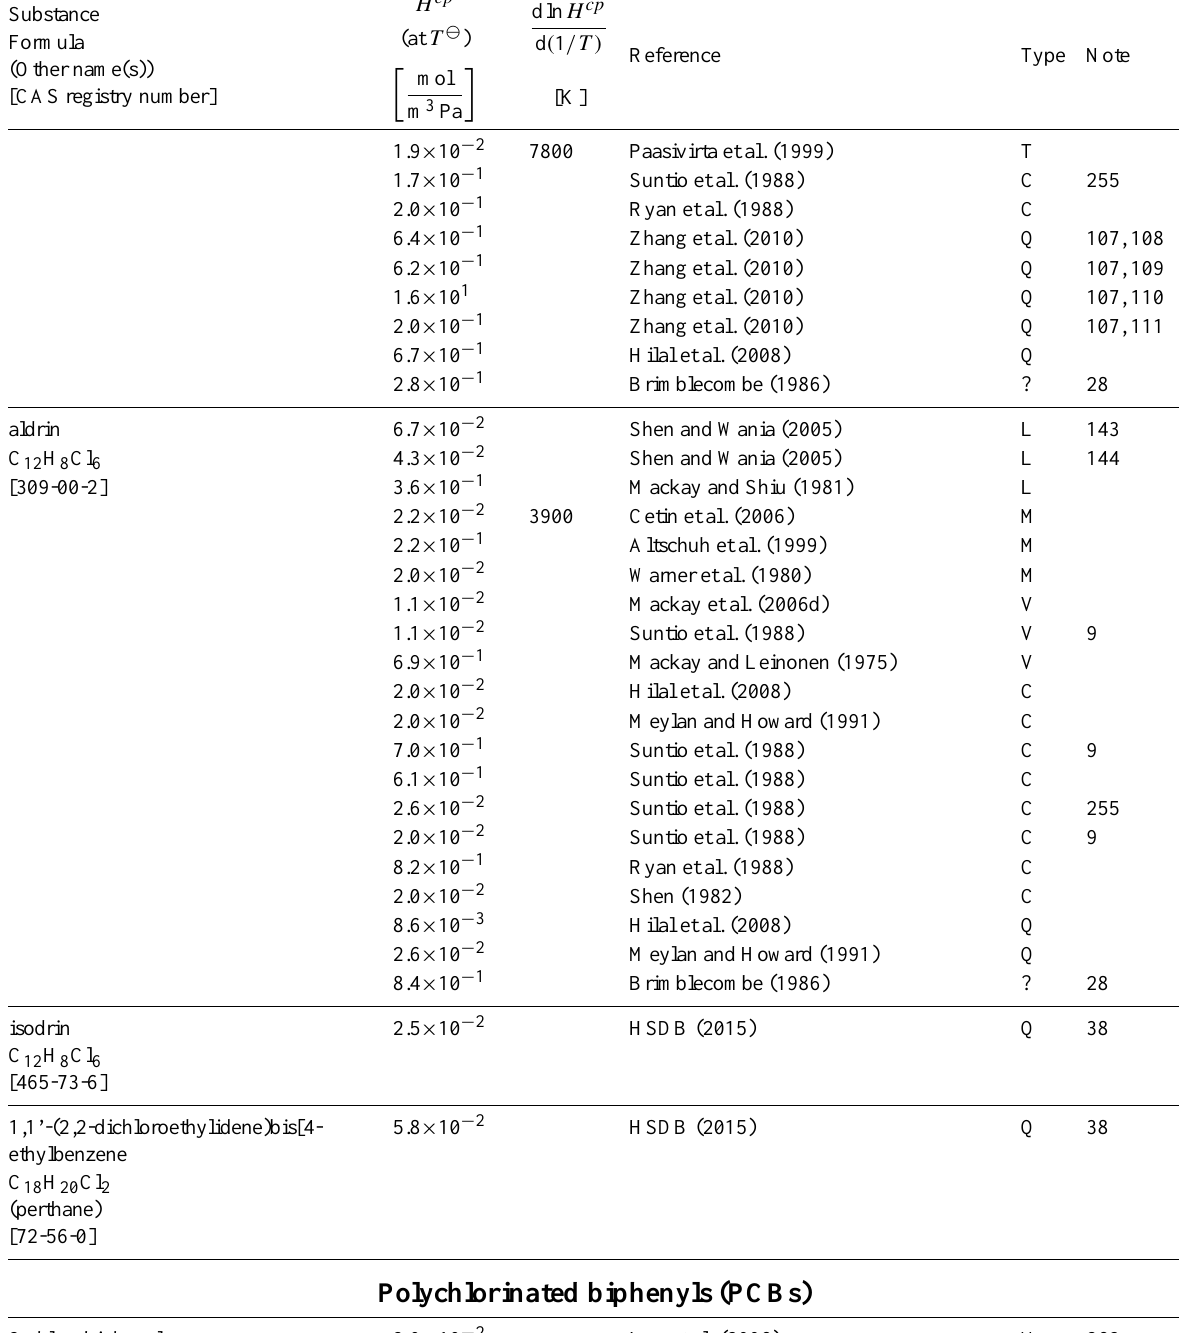
Table 6: Henry’s law constants for water as solvent